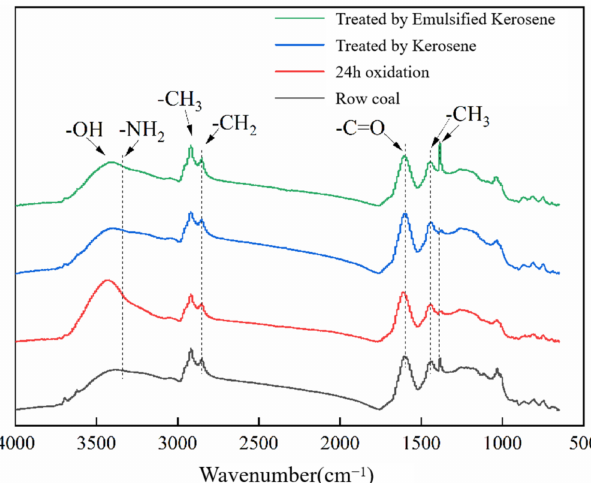
Figure 13. Functional groups on oxidized coal treated by kerosene and emulsified kerosene. For conventional conditions (only kerosene), the collector and dosage were 500 g/t kerosene. For the mixture reagent (emulsified kerosene), the equivalent kerosene dosage was also kept as 500 g/t as a control